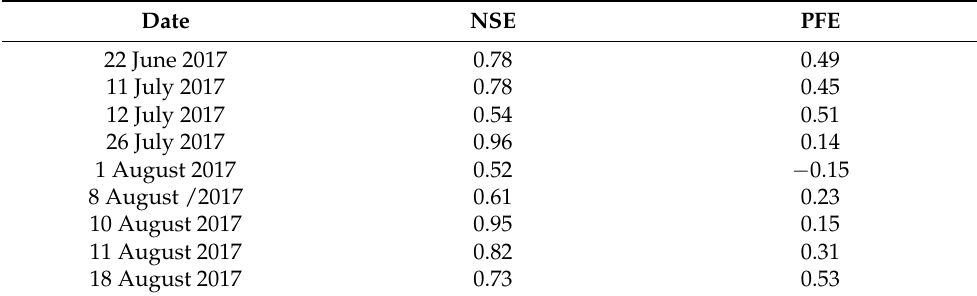
Table 2. Goodness-of-fit results for